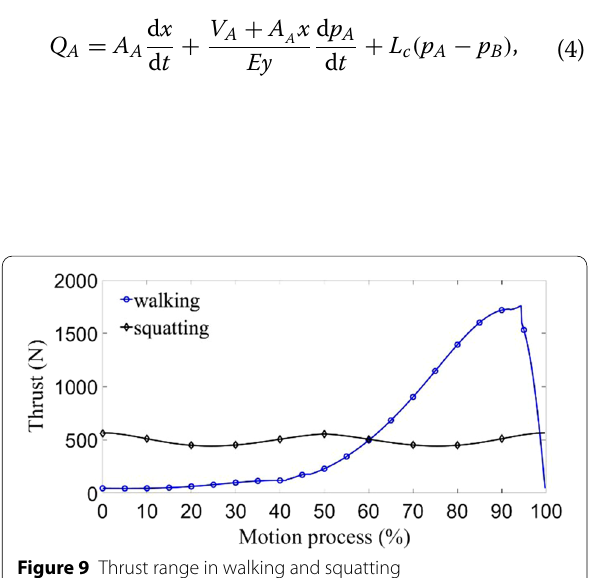
Figure 9 Thrust range in walking and squatting